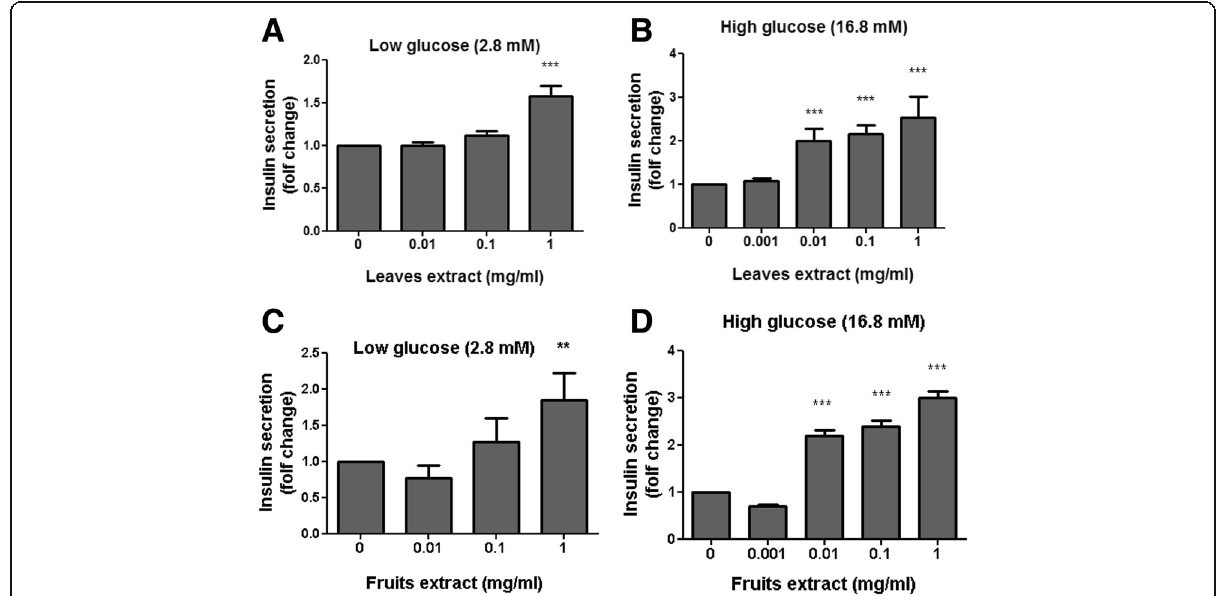
Fig. 7 S. spinosum extracts induced insulin secretion in Min6 cells. Min6 pancreatic beta-cells were grown as described and treated for 1 h with leaves ( a and b ) or fruits ( c and d ) S. spinosum extracts at various concentrations as indicated. Supernatant was collected at the basal state and after glucose induction of insulin secretion. The induction of insulin secretion and measurement of insulin secretion were performed as described in the Materials and Methods section. Results are mean ± SEM of five independent experiments, ** p < 0.005, *** p < 0.0005 compared to untreated cells by Student ’ s t -test